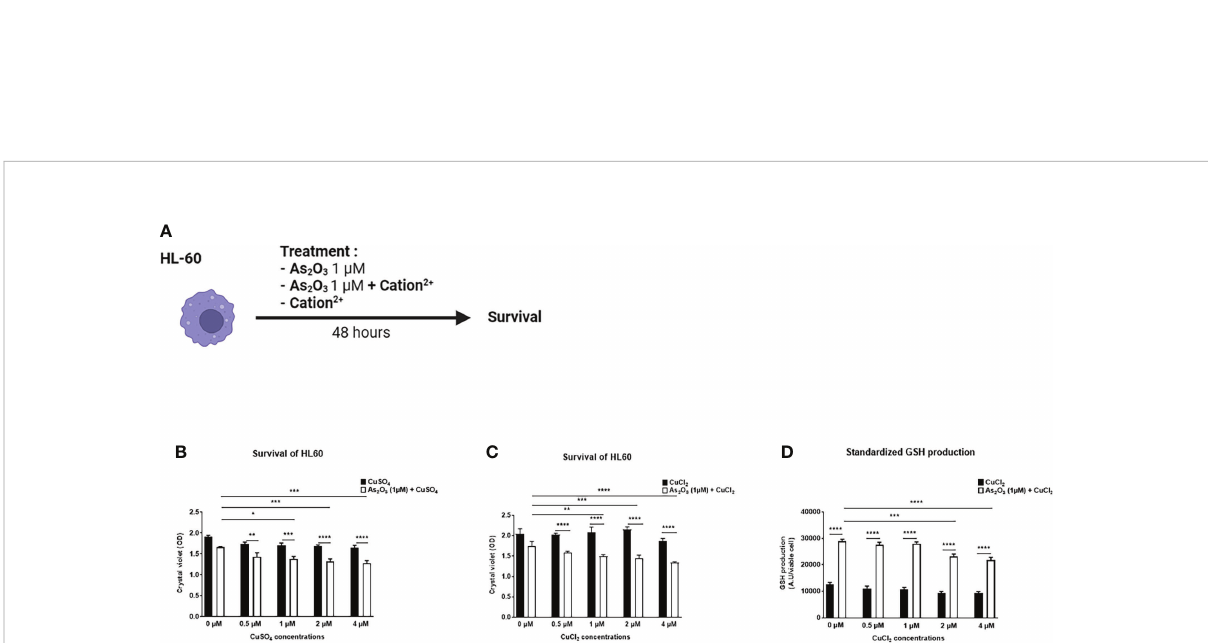
FIGURE 2 Effect of ATO ± Cu 2+ on cell survival and on GSH production of HL-60 cell line. (A) Schematic representation of the in vitro experiment on HL- 60 cells. The cells were treated for 48 hours with arsenic trioxide at 1 m M +/- different divalent cations. The survival of HL-60 cells was measured by absorbance. (B, C) Cell viability of HL-60 cells in culture measured after treatment during 48 hours with one concentration of ATO (1µM) and with increasing concentrations of CuSO 4 /CuCl 2 (0-4 µM). (D) Standardized GSH level produced by HL-60 cells in culture after treatment during 48 hours with one concentration of ATO (1 µM) and with increasing concentrations of CuCl 2 (0-4 µM) The results obtained by spectro fl uorometry using monochlorobimane were divided by cell viability established by colorimetry (crystal violet). NS: not signi fi cant; *p<0.05; **p<0.01; ***p<0.001; ****p<0.0001. The results are the mean of 6 replicates per